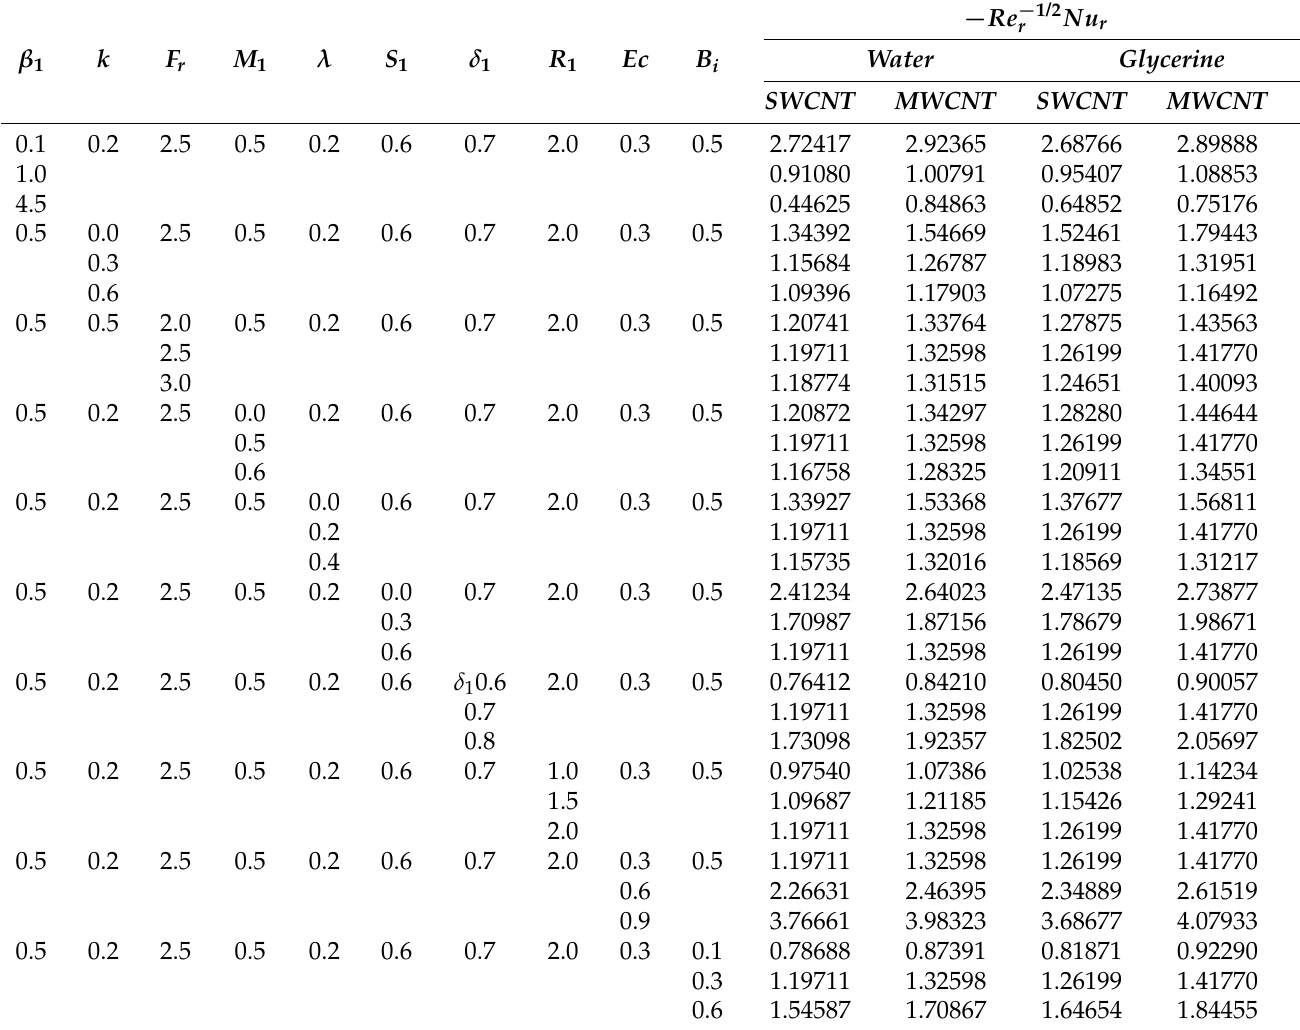
Table 3. Nusselt number for water and Glycerine θ f =